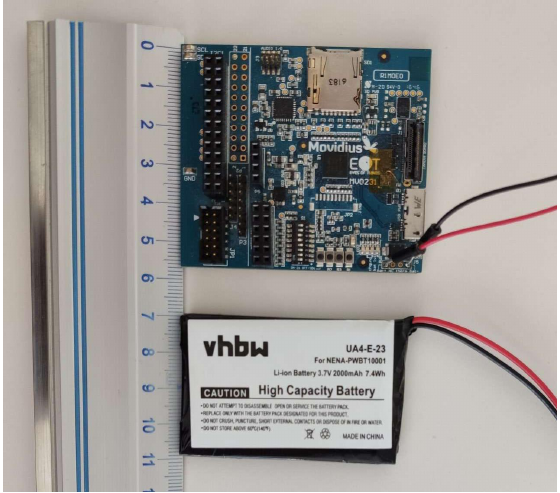
Figure 1. EoT platform.